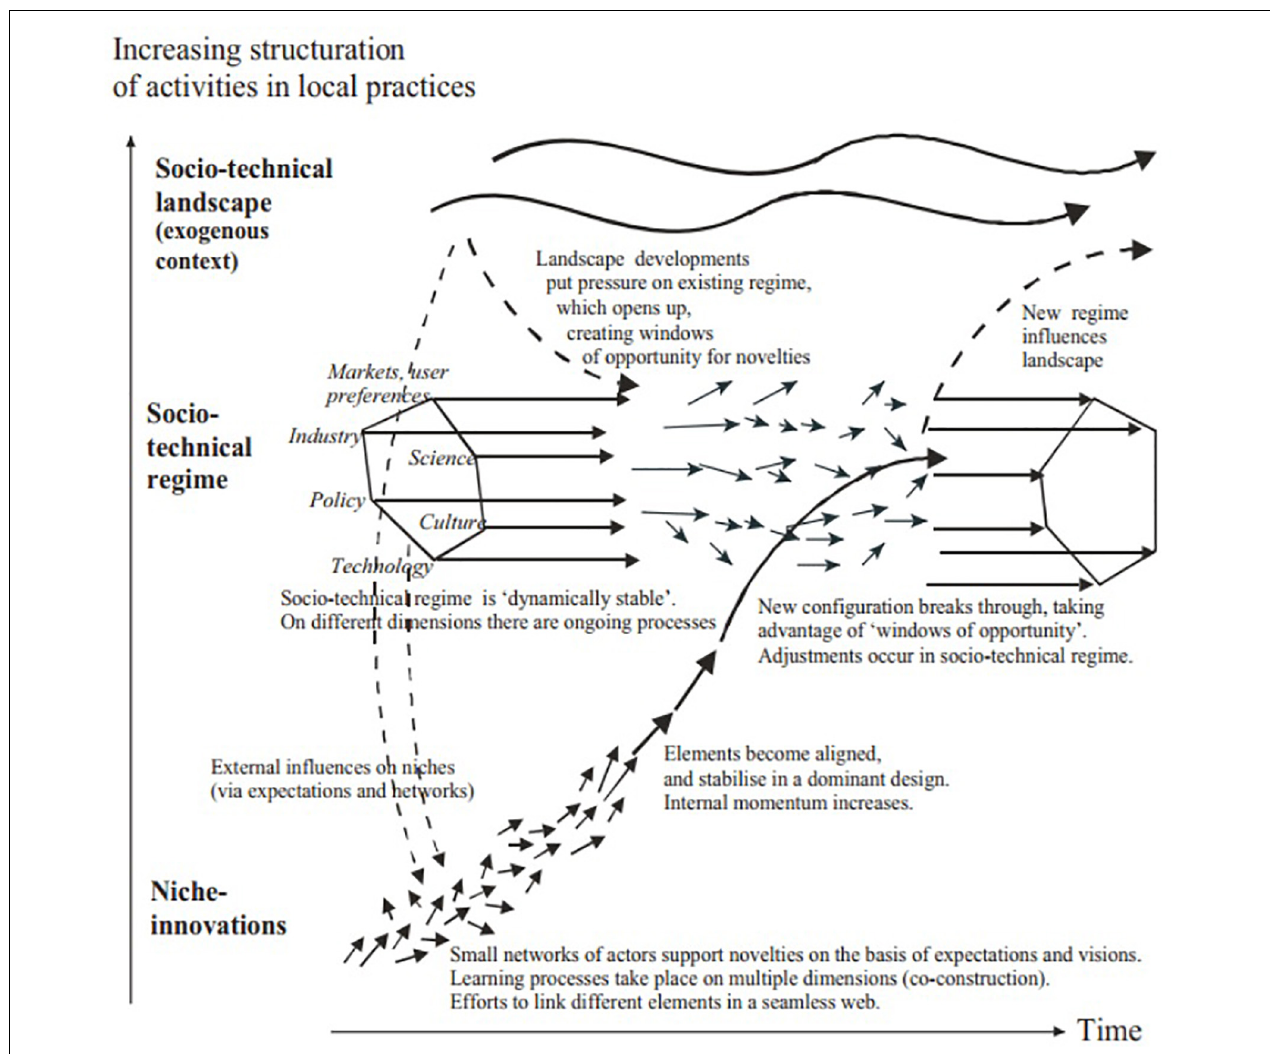
FIGURE 3 | Multi-Level Perspective on transition pathways. Source: Geels and Schot (2007, p. 401, adapted from Geels, 2002, p. 1263).